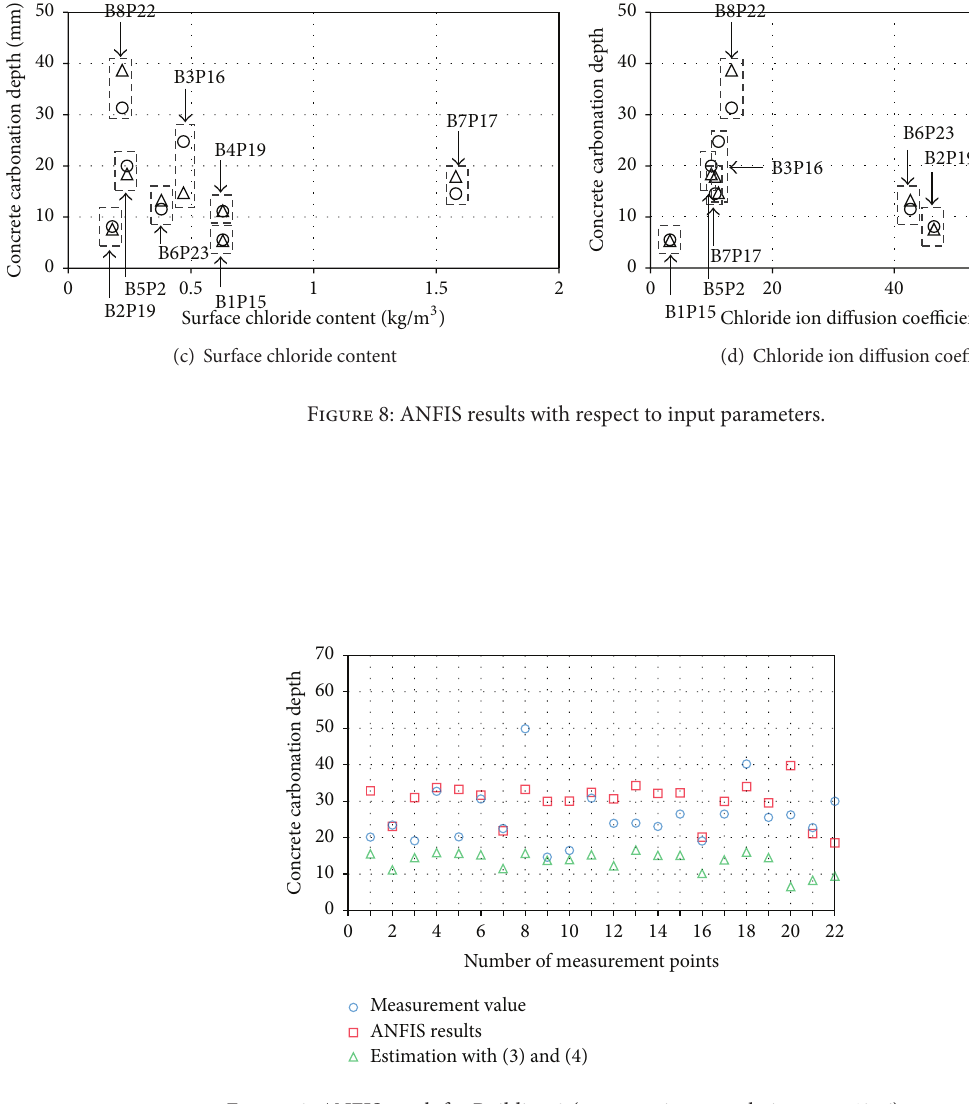
Figure 9: ANFIS result for Building 9 (construction completion year: